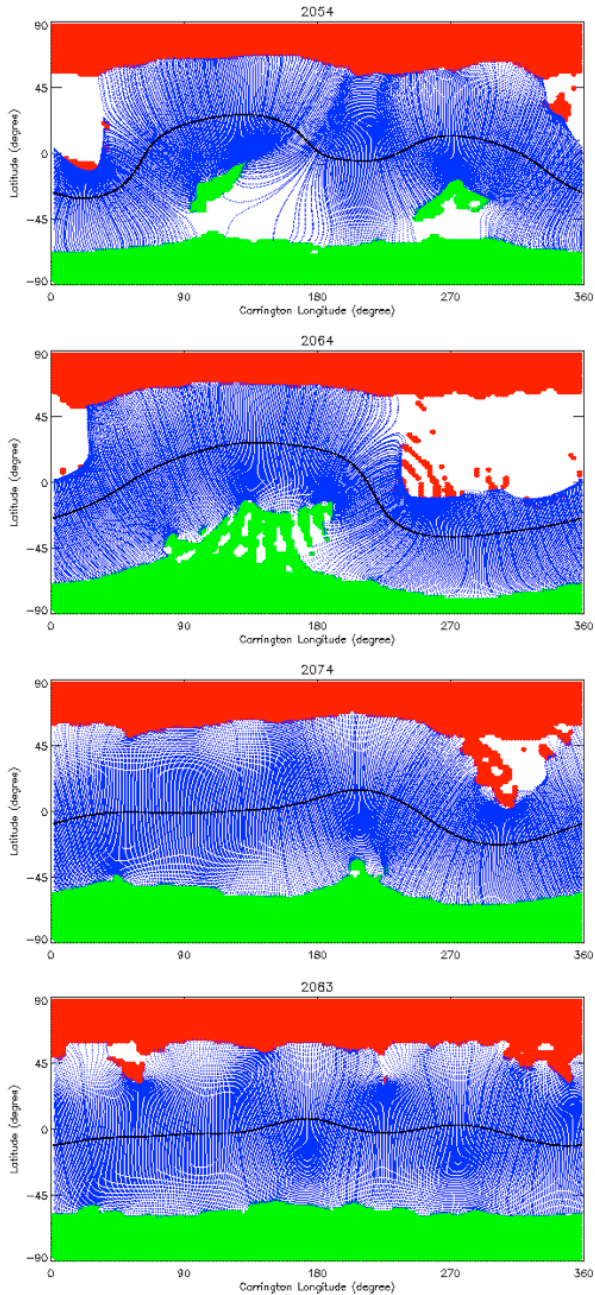
Fig. 2. Selected snapshots of NSO/GONG synoptic coronal hole plots (Latitude versus Carrington Longitude) for Carrington Rota- tions during the course of the present survey period (dates covered by these rotations can be found in Table 1 for STEREO A). Patches of green and red color indicate the location of the coronal holes and their magnetic polarity (green denotes positive polarity, red nega- tive polarity). The neutral line, which may be identified with the equatorial streamer belt, is drawn in